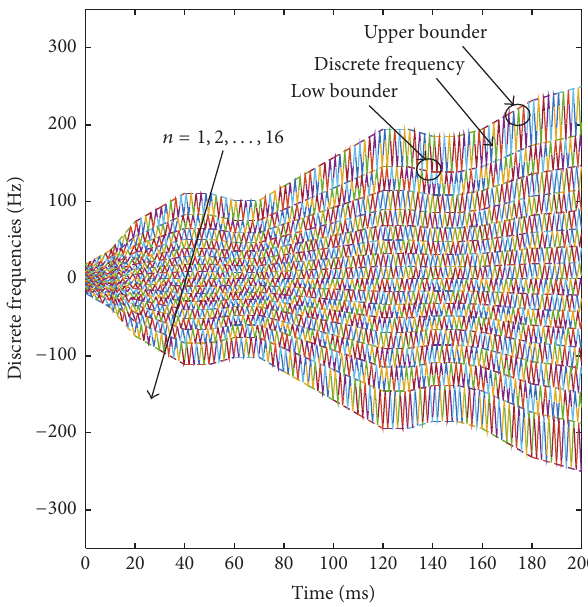
Figure 4: Calculated discrete frequency parameters for each branch ( 𝑁 = 16 ). These results are calculated from (25)–(29) and (31) with the DPSD given in Figure 3 and they will be used in (21) to generate the nonstationary Rayleigh